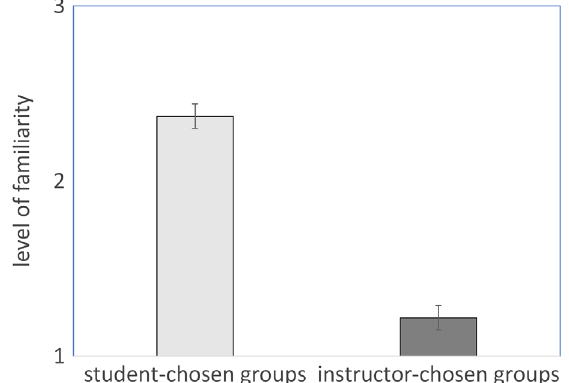
FIG. 4. Level of familiarity of students within student-chosen groups versus instructor-chosen groups.